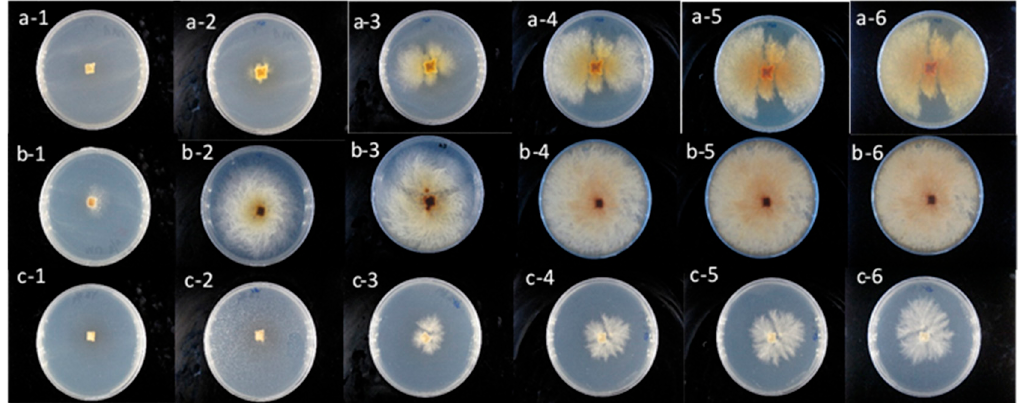
Figure 1. The growth patterns of HS mycelia on the Petri dish plate. The media used were: ( a ) malt extract agar medium, ( b ) potato dextrose agar medium, and ( c ) yeast extract agar medium. Numbers indicated photo records every 5 d.